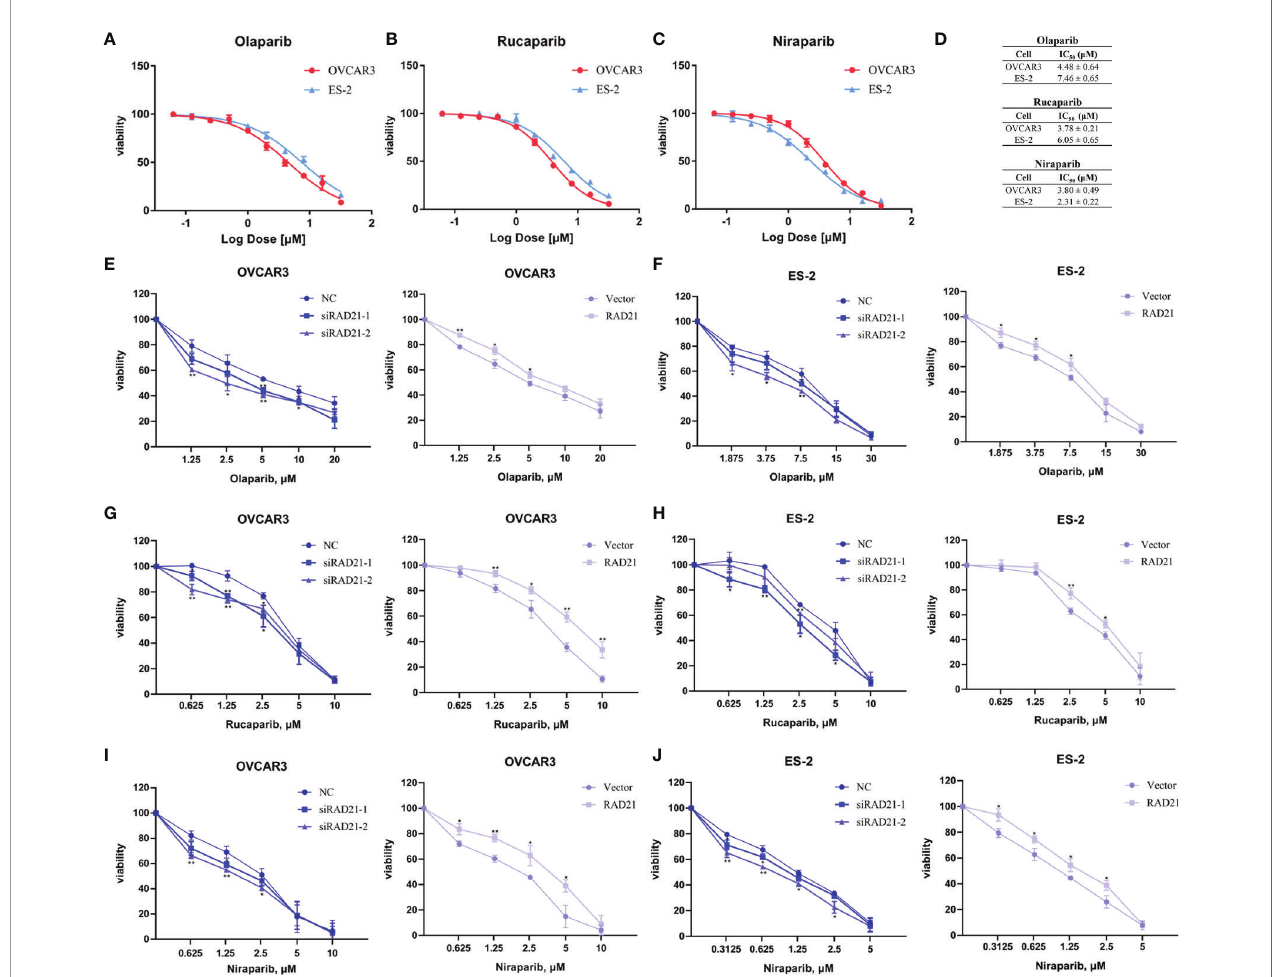
FIGURE 3 | RAD21 overexpression reduced poly(ADP-ribose)polymerase (PARP) inhibitor sensitivity in ovarian cancer cells. (A – C) Cell viability in cells treated with olaparib (A) , rucaparib (B) , and niraparib (C) analyzed using the Cell Counting Kit-8 (CCK8) assay. (D) IC 50 values in cells treated with PARP inhibitors. (E, F) The effects of RAD21 on olaparib treated OVCAR3 (E) and ES-2 (F) cell proliferation. (G, H) The effects of RAD21 on rucaparib-treated OVCAR3 (G) and ES-2 (H) cell proliferation. (I, J) The effects of RAD21 on niraparib-treated OVCAR3 (I) and ES-2 (J) cell proliferation. Data were represented as mean ± SD (n = 3). * p < 0.05; ** p <